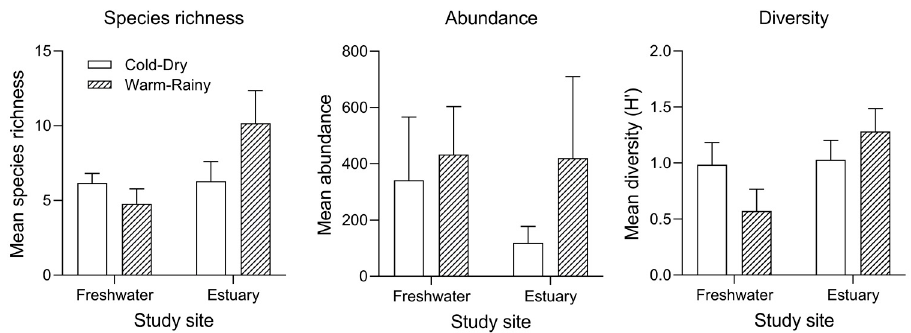
Figure 4. Variations in mean species richness, abundance, and diversity of fish assemblages with study site and season in the lower Nakdong River, South Korea.